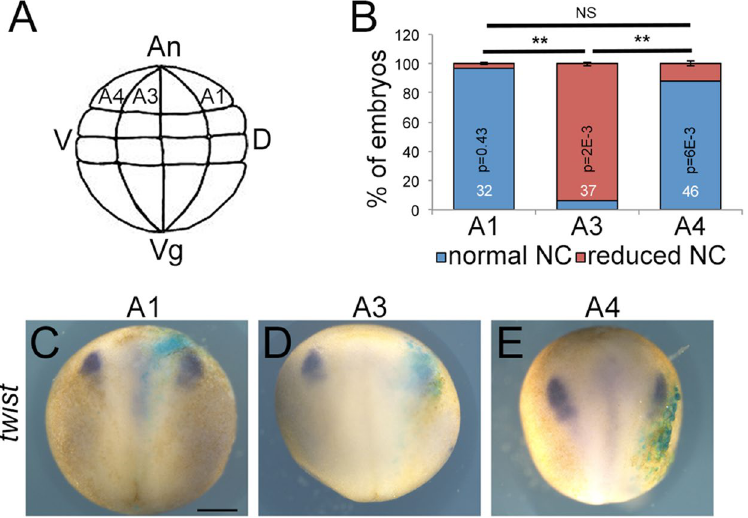
Figure 6. MarvelD3 depletion targeting a neural crest progenitor inhibits twist expression. ( A ) Scheme of the lateral view of a 32-cell stage embryo (adapted from Xenbase). The blastomeres are identified with from dorsal ( D ) to ventral (V) as A1 (mainly neural plate), A3 (mainly neural crest and epidermis) and A4 (mainly epidermis); An, animal; Vg, vegetal. ( B ) Neural crest induction (stage 15) was quantified by analysing twist expression by WISH in embryos injected at 32-cell stage either in the A1, A3 or A4 blastomere; Student t-test p values and the number of embryos analysed is indicated on the graph; blue bar, normal neural crest; red bar, reduced neural crest. Expression of the neural crest marker, twist by WISH in embryos injected in A1 ( C ), A3 ( D ) or A4 ( E ) blastomere, respectively at 32-cell stage. β -galactosidase (light blue staining) is expressed in the cells derived from the targeted blastomere. Note the reduction of twist expression only in A3 injected embryos. Scale bar, 500 μ m.